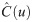
Correlation functions averaged over all pairs of connected cells in respective group combinations: external rate correlations C^(u) (solid black); estimates for network correlations from full spiking network simulations (orange line with shaded green area showing standard deviation of 5 seconds batched estimates) and analytical estimates of order 4 (dashed green).(A) For network under normal activity. (B) For network under spike-triggered stimulation (†). Boxes in the middle show zooms from C(†)(u) from A and B.